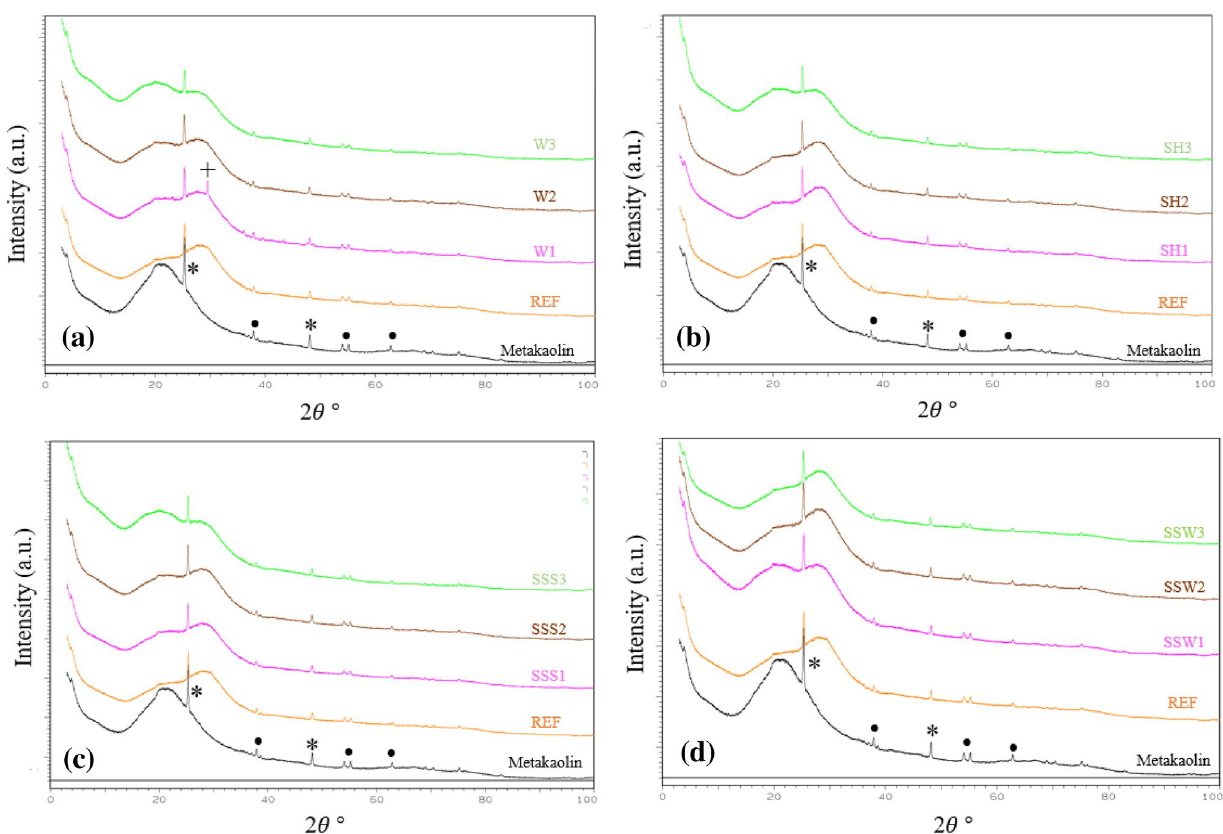
Fig. 10 XRD of raw Metakaolin compared to a group W, b group SH, c group SSS, and d group SSW. Identified phases are quartz (